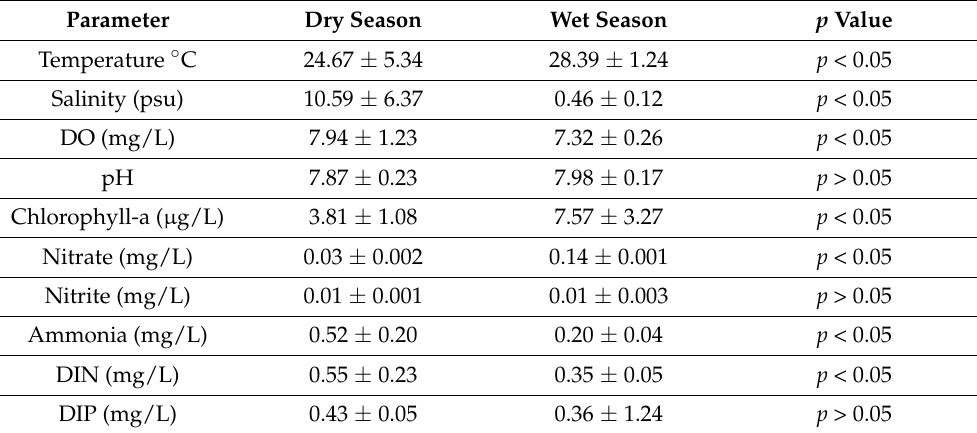
Table 1. Water quality parameter of the Meghna River